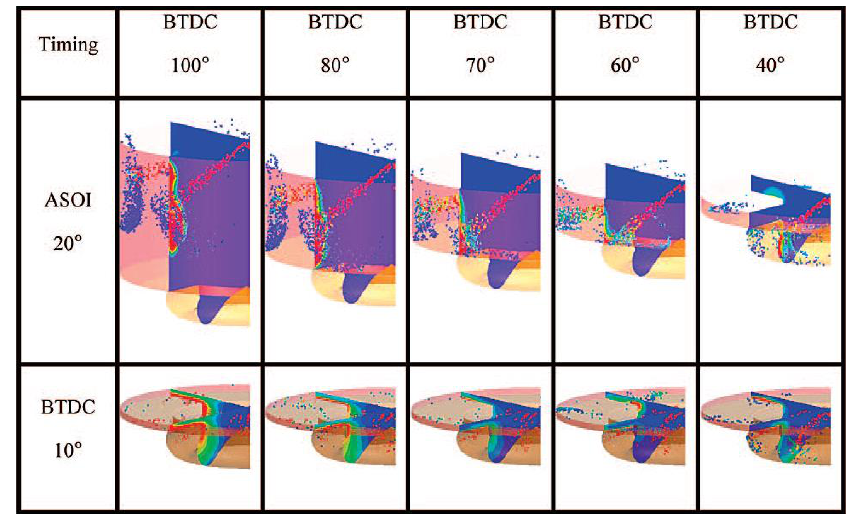
Figure 5. Air–fuel distribution at various injection timings [63]. Reprinted with permission from Energy & Fuels. Copyright 2019 American Chemical Society. After Start Of Injection (ASOI).